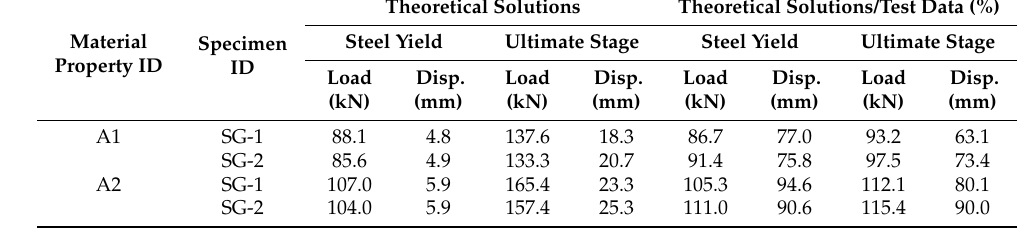
Table 8. Summary of theoretical solutions.